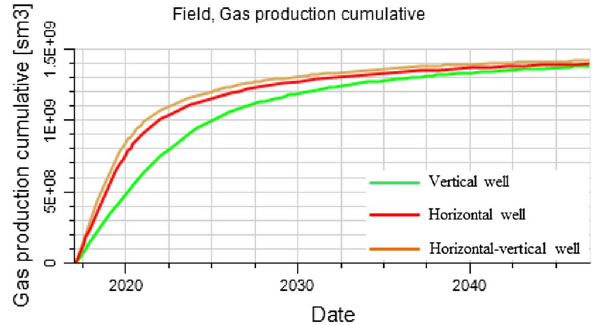
Fig. 8 Demonstration of well pattern—the cumulative gas production curve of the sweet